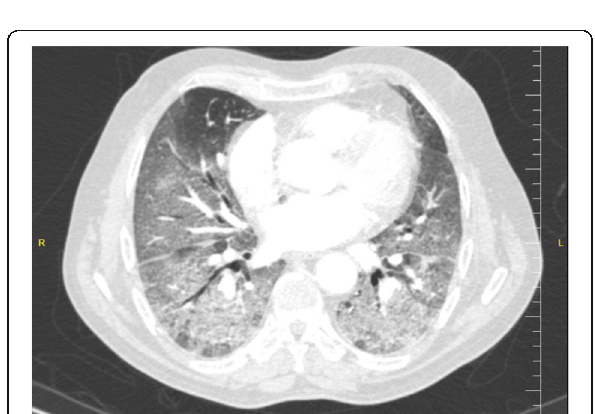
Fig. 5 An axial chest CT from a 60-year-old man with COV İ D-19 pneumonia. Non-contrast-enhanced chest CT image demonstrated extensive ground-glass opacities seen in both lungs, involving almost all lower lobes, giving a white lung appearance, with air